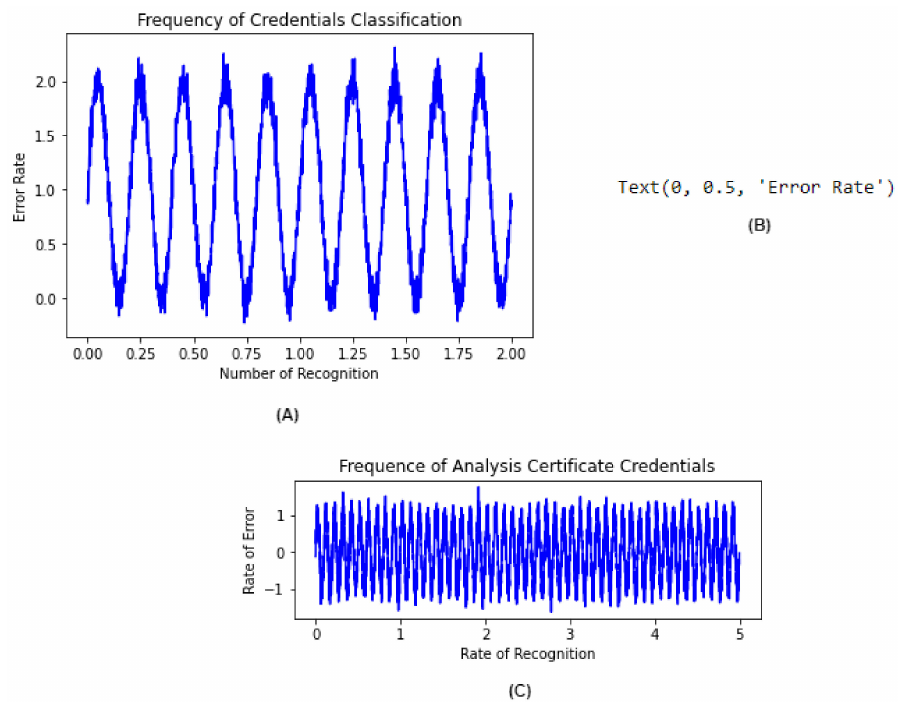
Figure 6. Certificate pre-verification/classification. ( A ) Calculate frequency of credential classification, ( B ) error rate, and ( C ) calculate frequency of analysis.